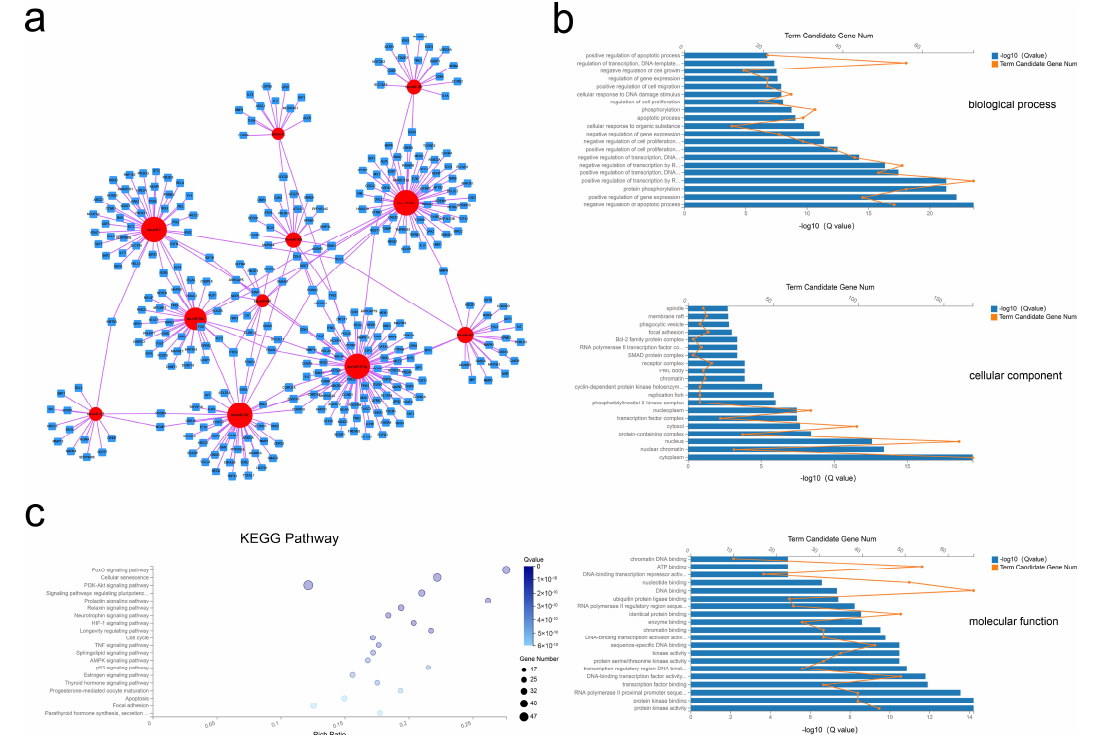
Figure 5. Exosomal miRNA–mRNA network construction and analysis. ( a ) Global view of the exosomal miRNA–mRNA network, including 11 miRNAs (red circles), and 328 mRNAs (blue squares). ( b ) The top 20 GO terms including biological process, cellular component, and molecular function. ( c ) Advanced bubble chart of the 20 most enriched KEGG